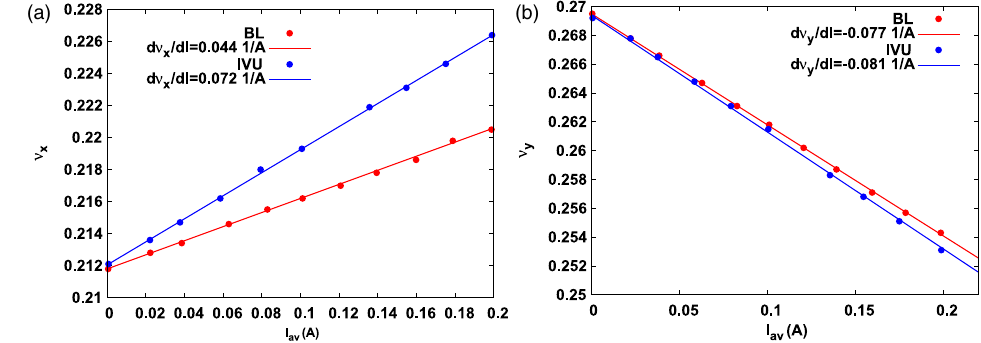
FIG. 8. Horizontal (a) and vertical (b) betatron tune shifts versus average current for lattices with local β x -bumps in IDs location, where the local beta functions β x ¼ 31 m and β y ¼ 3 . 6 m